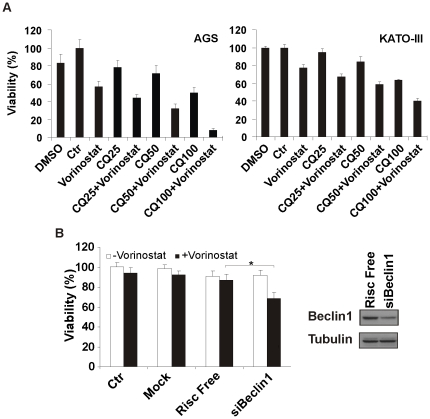
Effect of vorinostat-induced autophagy inhibition.(A) AGS and KATO-III cells were treated with 5 µM vorinostat and different concentrations of chloroquine (CQ). Cell viability was assessed after 12 hours using crystal violet staining and control (Ctr) was set as 100%. (B) KATO-III cells were transfected with siRNA against Beclin 1 (siBeclin1) or with non-targeting Risc Free siRNA or treated with Dharmafect I alone (mock). siRNA efficiency was confirmed by western blot analysis of Beclin 1 and Risc Free as a control. α-tubulin was used to show equal loading of proteins. Viability was measured after 12 hours vorinostat treatment using crystal violet staining. Viability of untreated control (Ctr) cells was set as 100%. *, P<0.05.